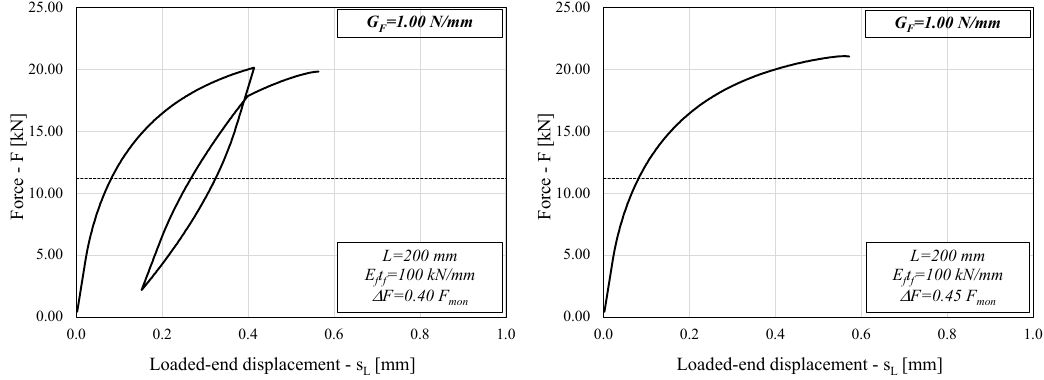
Figure 4. Load–slip curve (L = 200 mm, G F = 1.00 N/mm).